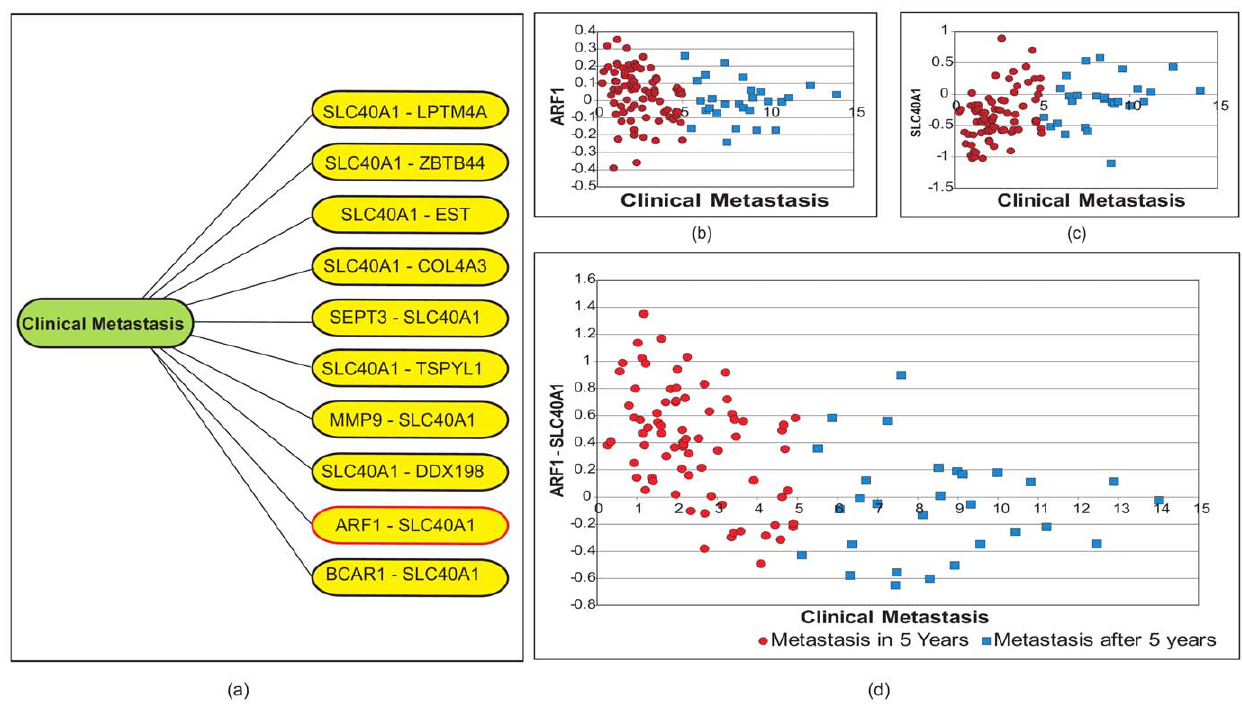
Figure 3. Application on the expanded_A dataset with 384,126 probe sets. Figure (a) shows of a k NN graph from the from Expaneded_A considering the clinical metastasis (year to relapse, a phenotypical ‘‘dummy’’ gene in the data set) as a sample query point. The multiple appearances of Ferroportin (SLC40A1) is noticeable in its neighboring metafeatures. The complete graph could not be visualized due to the limitation of existing tools [50]. Figure (b)–(c) show the correlation of ARF1 (ADP-ribosylation factor 1) and SLC40A1, (Ferroportin-1) with the the clinical metastasis , respectively. (d) The metafeature (ARF1-SLC40A1) shows better correlation with the clinical metastasis of each patient with respect to the feature (i.e., the ARF1, ADP-ribosylation factor 1, or SLC40A1, (Ferroportin-1) alone. This data indicates that, for those tumors that may relapse (and for which a different genetic signature may need to be found), the joint expression of ARF1 and Ferroportin may be associated to time to relapse. implementation is based the brute force k NN algorithm (Figure 1,